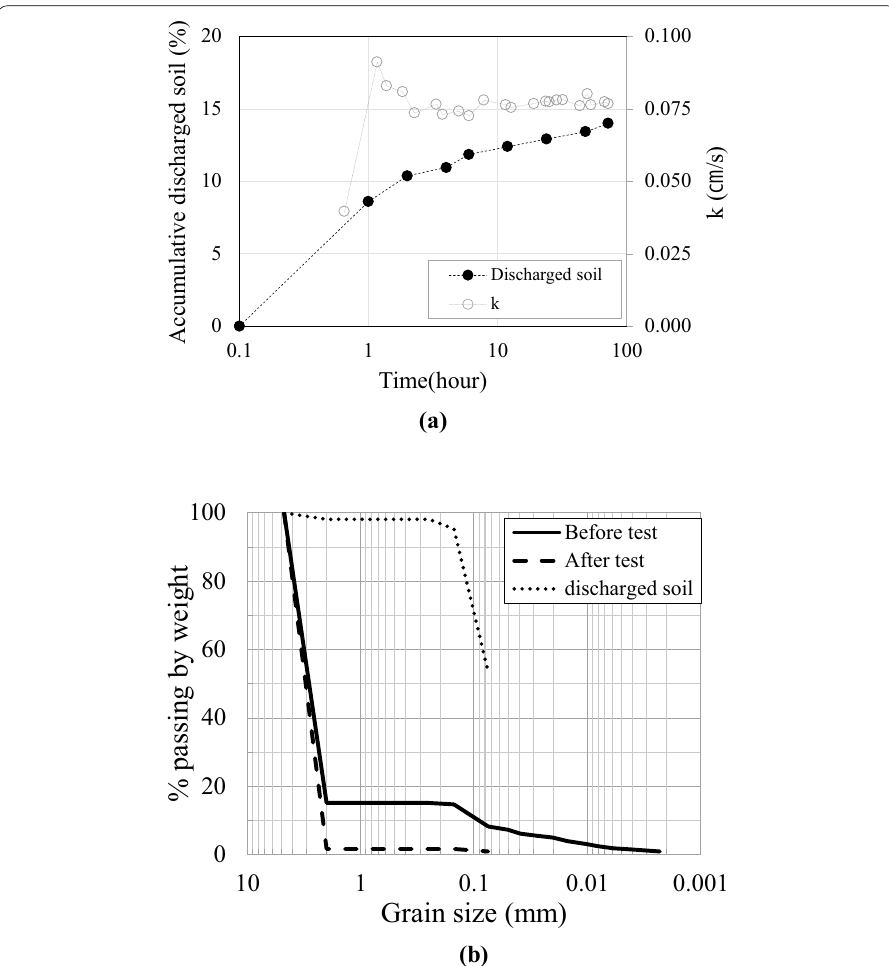
Fig. 5 Long‑term test results of gap‑graded silty sand: a accumulative discharged soil and k ; and b grain size distribution after the